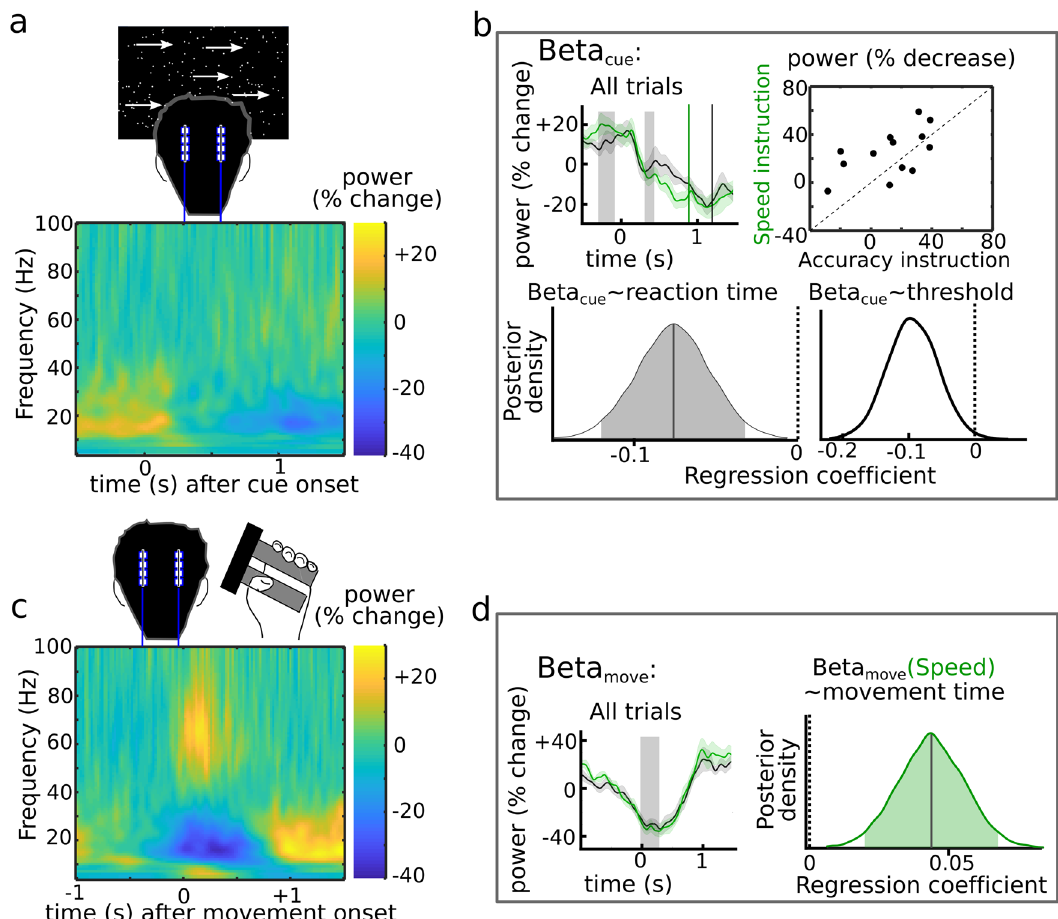
Fig. 3 | Local fi eld potential recordings from subthalamic nucleus. a Grand average for spectra aligned to the moving dots cue. B Results for cue-aligned changes in beta (~13 – 30Hz) power (Beta cue ) measured as change in beta power from precue (300 – 100ms precue) to post cue (320 – 400ms post cue) across participants ( n =13). C Grand average for spectra aligned to movement onset. D Results for movement-related (0 – 300ms post-movement) changes in beta